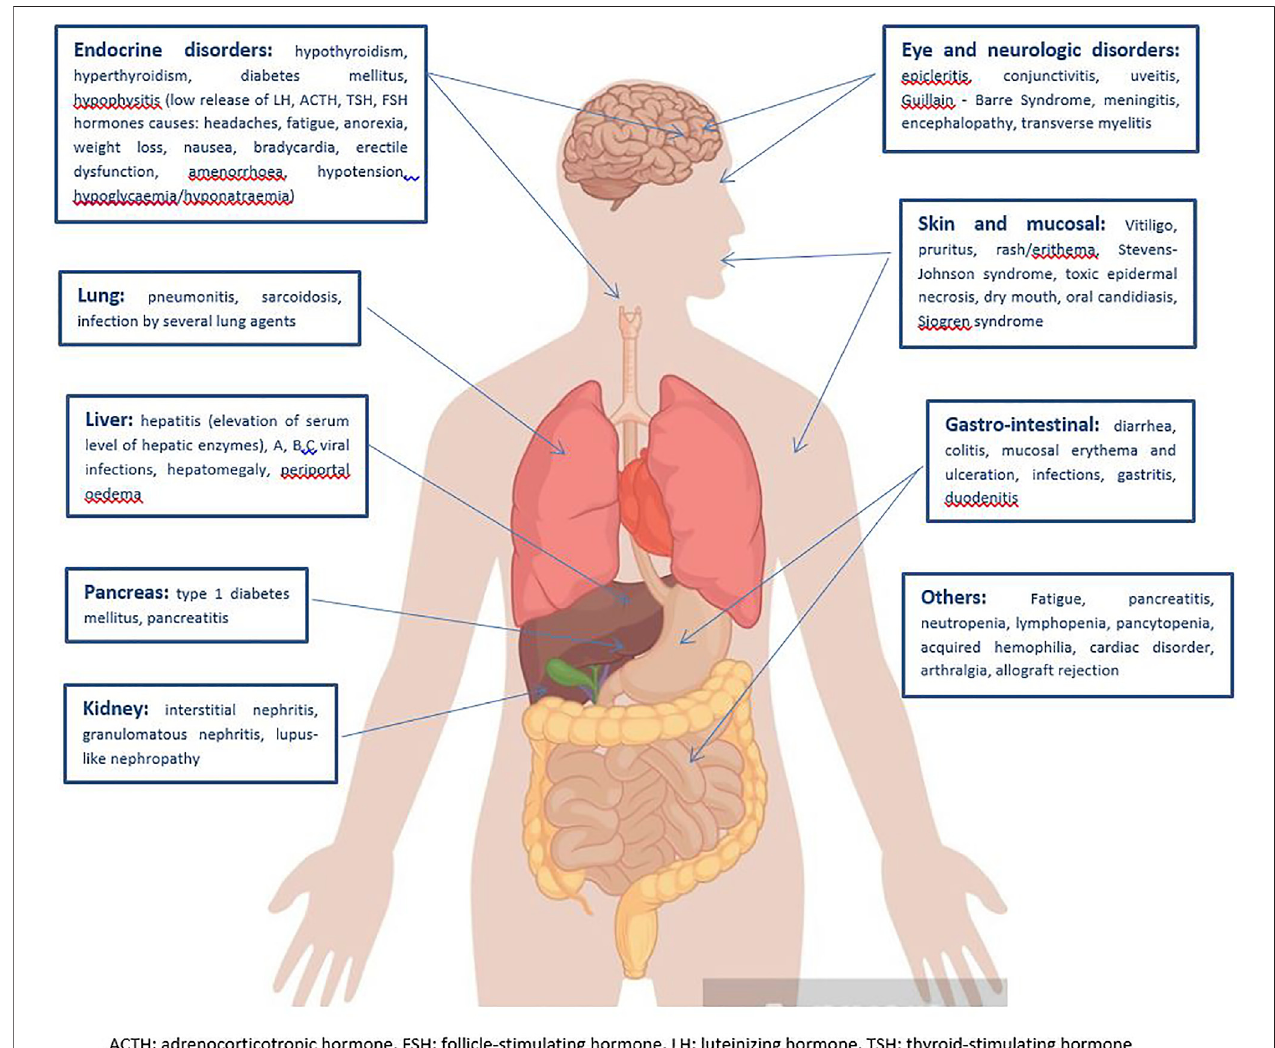
FIGURE 2 | Clinical spectrum of irAEs per each affected organ (Michot et al., 2016; Martins et al., 2019).